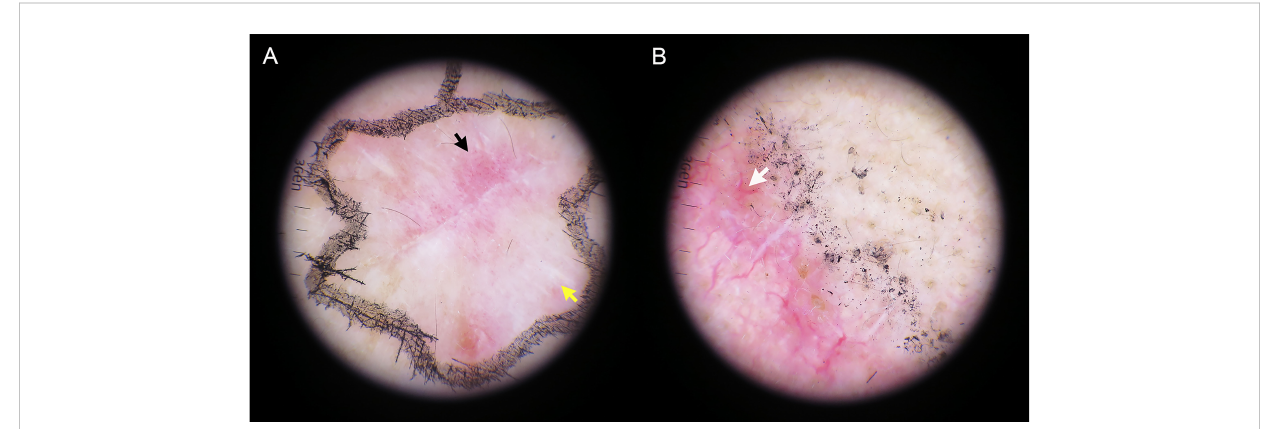
FIGURE 3 The dermatoscopic appearance of hrSCC after complete incisional biopsy. (A) Glomerular vessels (black arrow) coalescing with shiny white strands (yellow arrow) are seen. (B) A predominantly white color intertwined with a branch-like linear vessel (white